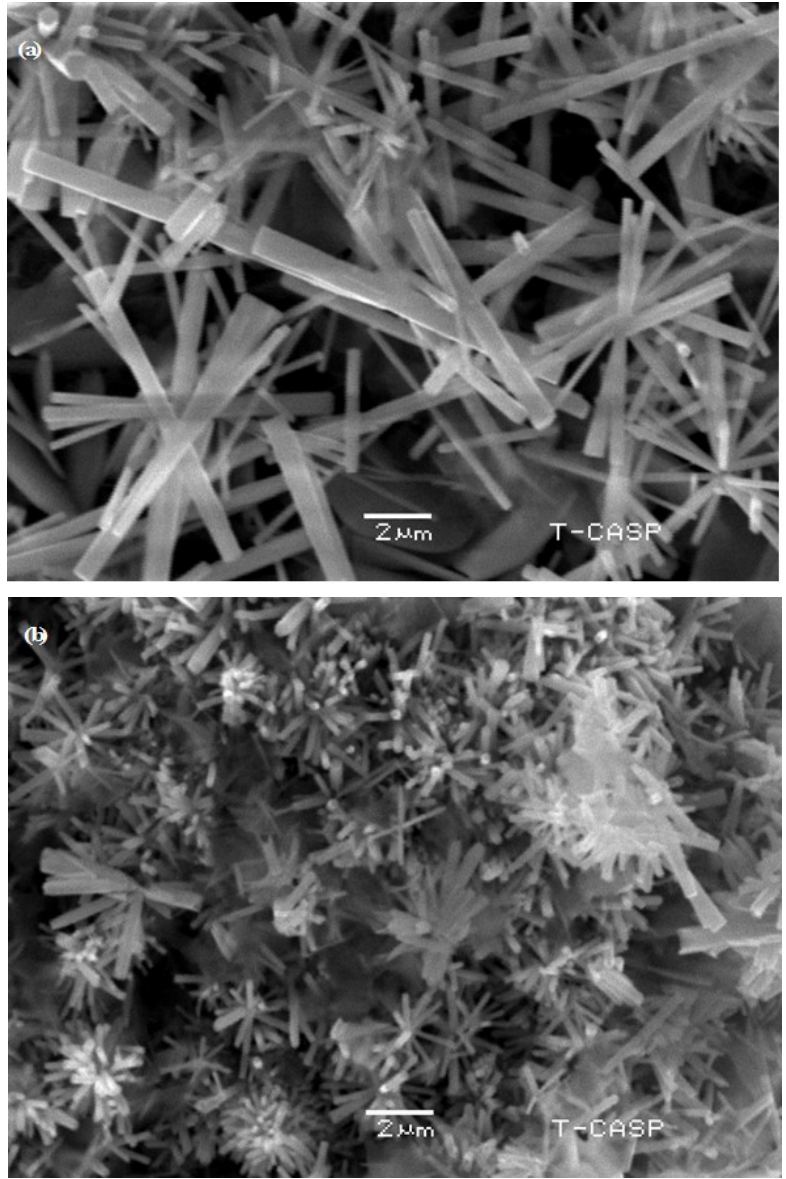
Figure 6. ( a ) Ca-doped ZnO nanorods on unseeded substrate; ( b ) Ca-doped ZnO nanorods on seeded